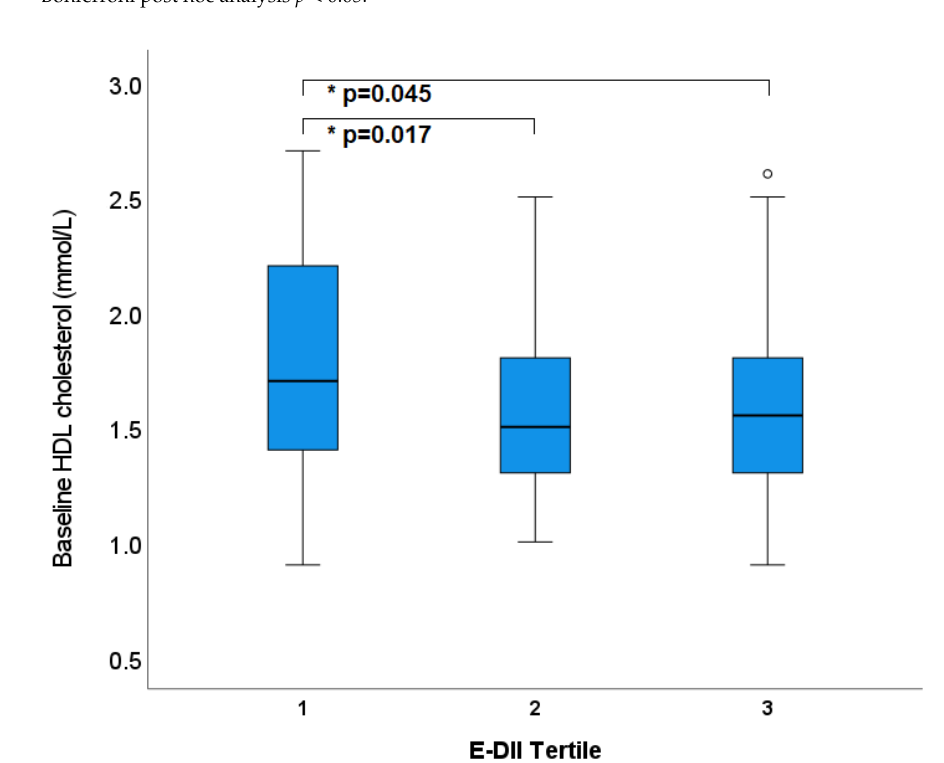
Figure 4. Tertiles of Dietary Inflammatory Index (adjusted for energy) and HDL cholesterol at baseline. * p values represent statistical significance determine by LMEM. Circles outside error bars represent outliers.